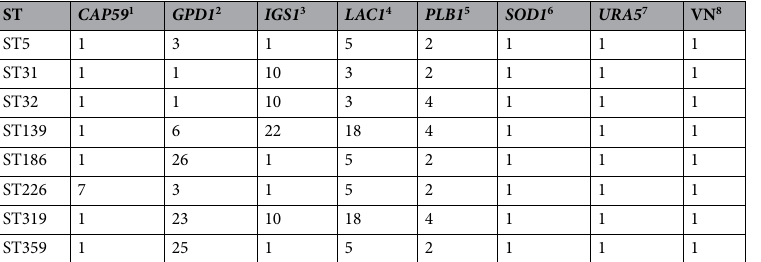
Results Demographic Data of the Clinical Isolates.